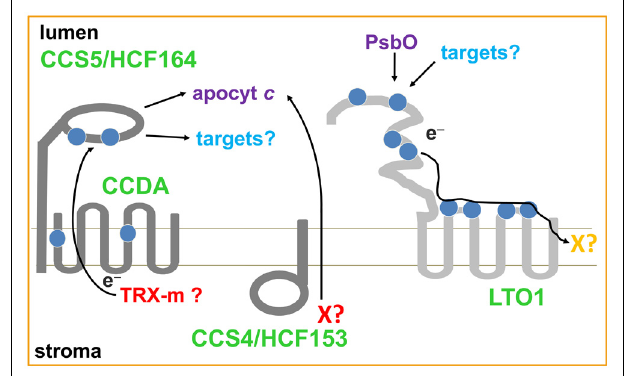
FIGURE 1 | Trans -thylakoid thiol metabolizing pathways. The disulfide-reducing (CCDA, CCS5/HCF164 and CCS4/HCF153) and thiol-oxidizing pathways (LTO1) are represented in dark and light grey, respectively. Cysteines are represented as blue balls. Electron ( e − ) routes are indicated by arrows.The topology of CCS4/HCF164 is hypothetical but the positive-inside rule predicts a stromal localization for the C-terminal domain of the protein. CCS5/HCF164 is a membrane anchored lumen-facing thioredoxin-like protein. LTO1 contains aVKOR-like membrane domain and a lumen-facing thioredoxin-like domain. Stromal reductants for the disulfide reducing pathways are indicated in red.The electron acceptor for the thiol-oxidizing pathway is indicated in orange.Thioredoxin- m (Trx-m) is the possible reductant for the CCDA-CCS5/HCF164 pathway.The CCS4/HCF153 pathway might be involved in the transport of a reductant such as glutathione or ascorbate (X?).The final electron acceptor of the LTO1-dependent pathway is not known and is postulated to be a phylloquinone (X?). CCDA and LTO1 topology was deduced